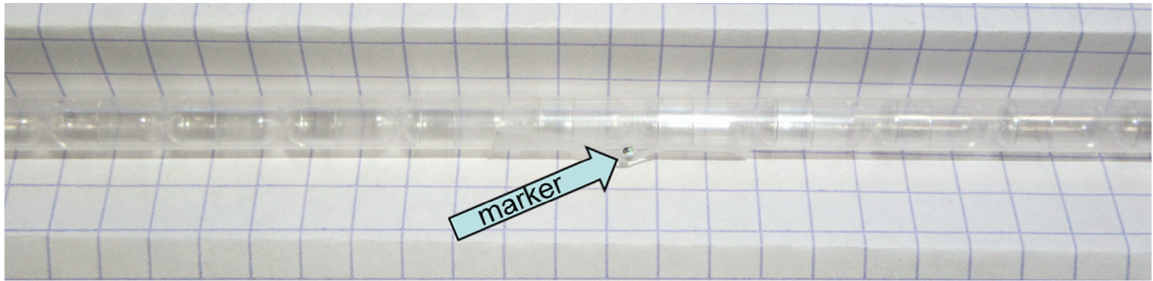
Figure A1. An example of the application of a magnetic marker for centering of the capsule compensational sample holder. As indicated, it is hard to get better reproducibility than about 0.5 mm.